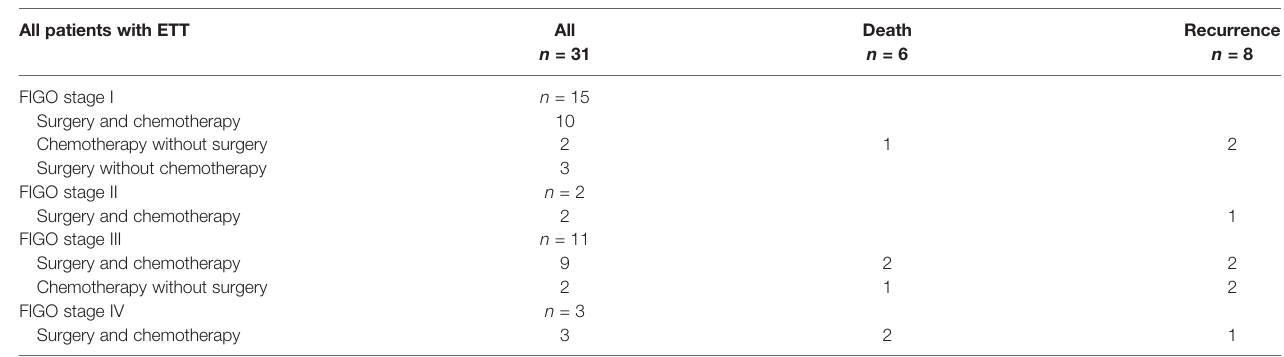
FIGO, International Federation of Gynecology and Obstetrics.